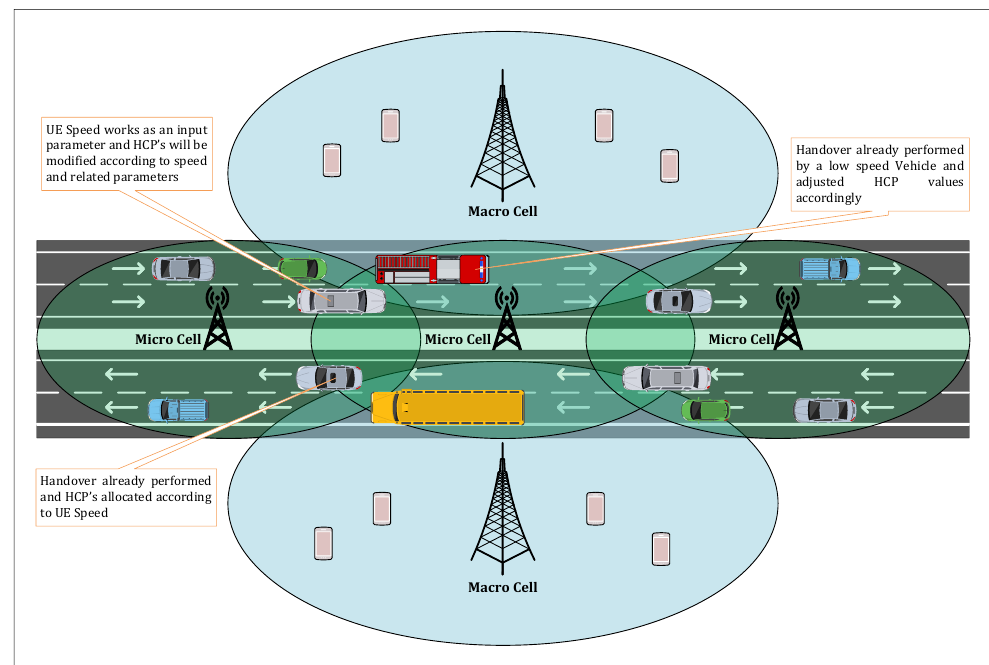
Figure 6. Illustration of Velocity Aware Handovers in